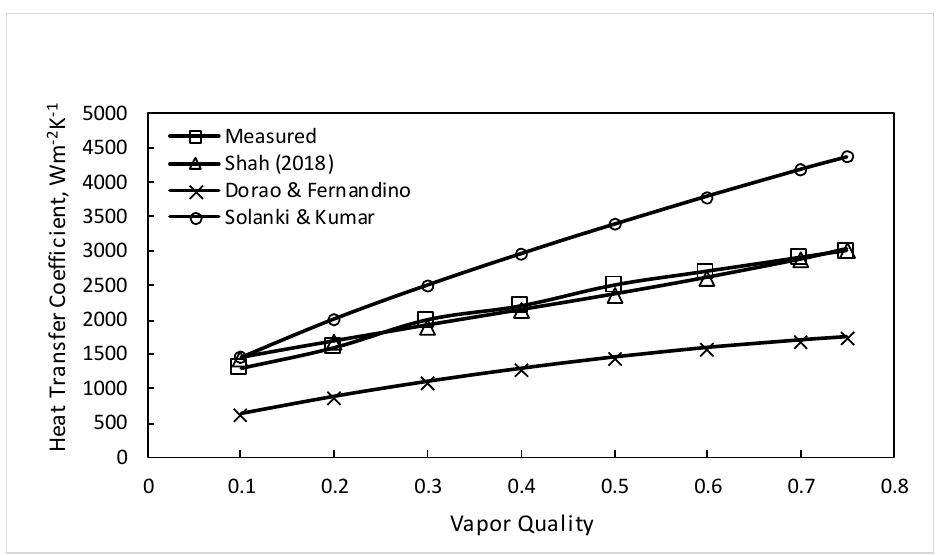
Figure 3. Comparison of the data of Derby et al. [51] in a semi-circular channel with various correlations. T SAT = 35 K, G = 75 kgm −2 s −1 , We GT = 19.